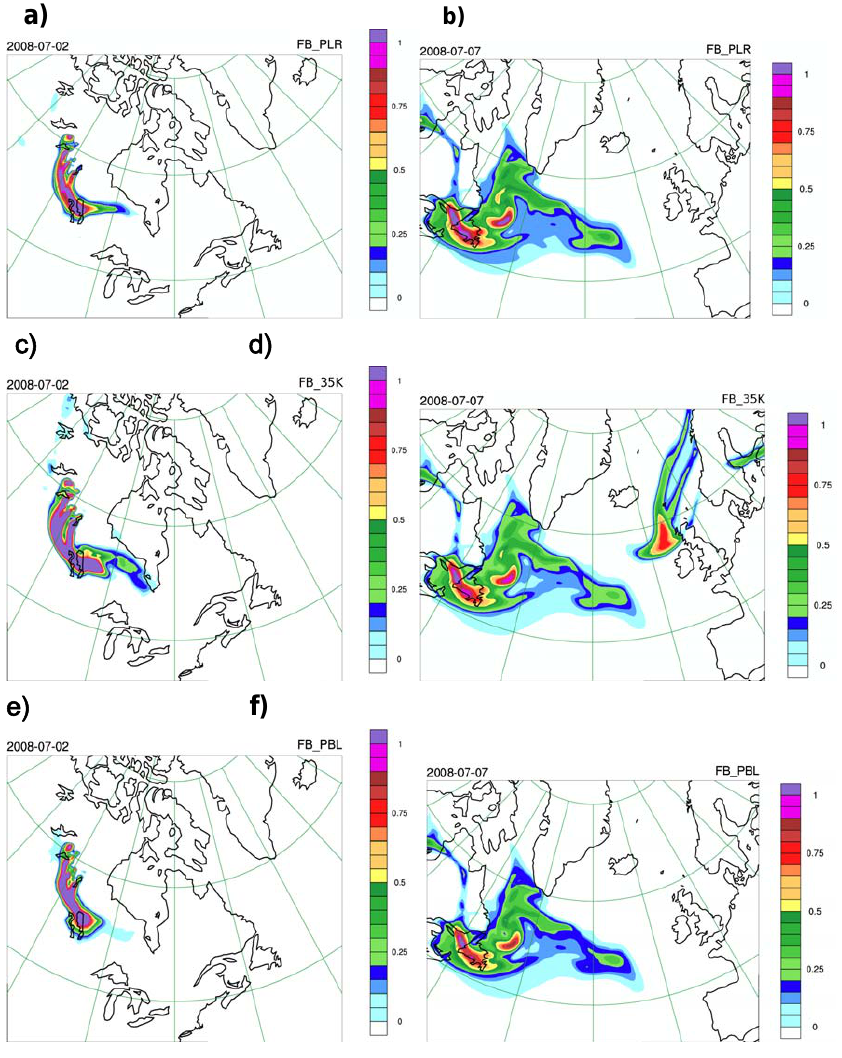
Fig. 15. Normalized WRF-Chem Total Column CO for the North American plume over Canada on (a, c, e) 2 July and (b, d, f) 7 July. only weak evidence for enhanced aerosols at these